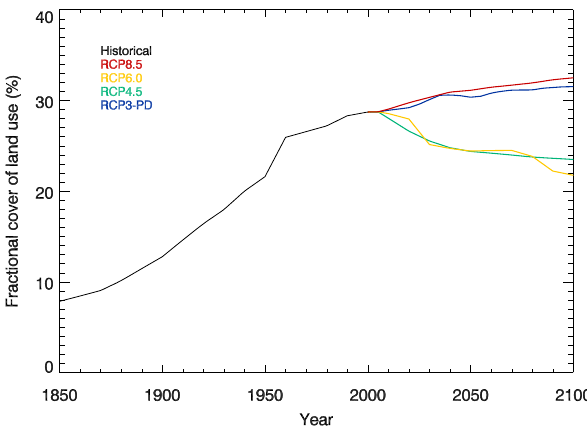
Fig. 11. Fractional coverage of anthropogenic disturbance, defined as the sum of crop and pasture, for the historical period 1860–2005, and up to 2100 following the 4 RCP scenarios, RCP3-PD (blue), RCP4.5 (green), RCP6 (yellow) and RCP8.5